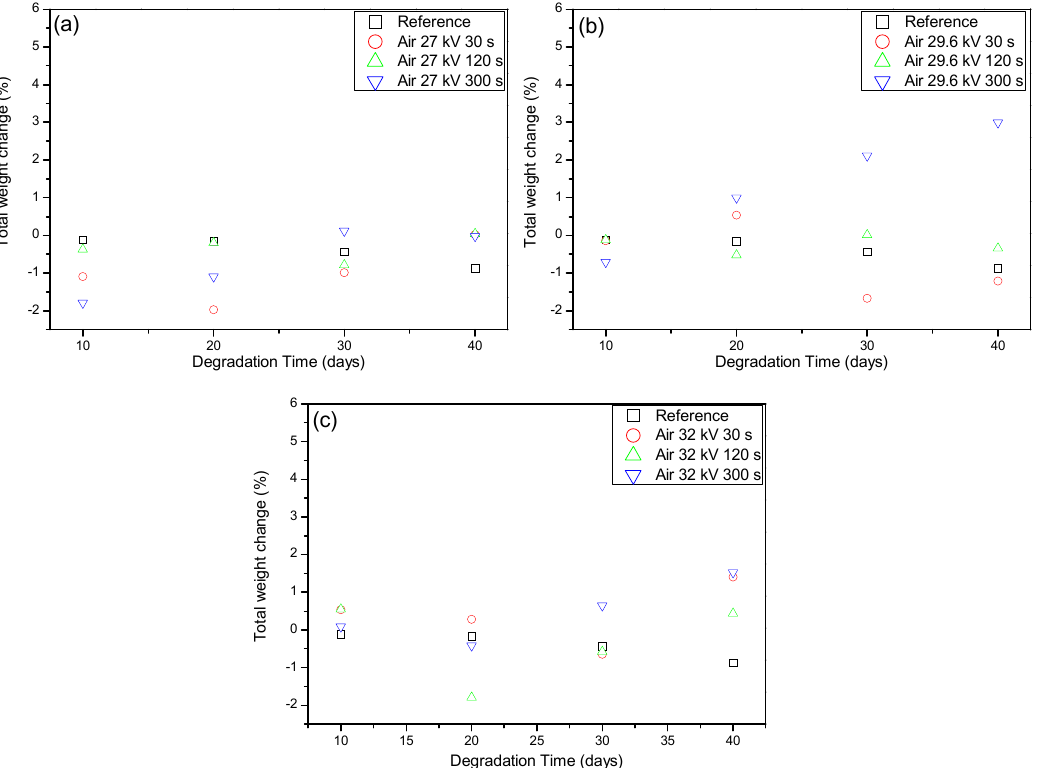
Figure 9. Percentage weight change of LDPE when introduced to the bacterial broth of Ps. aeruginosa for 10, 20, 30, and 40 days. These represent the percentage weight change in LDPE after degradation with plasma treatment times of 30, 120, and 300 s ( a ) shows changes for the different times at 27 kV ( b ) shows changes for the different times at 29.6 kV ( c ) shows changes for the different times at 32 kV.